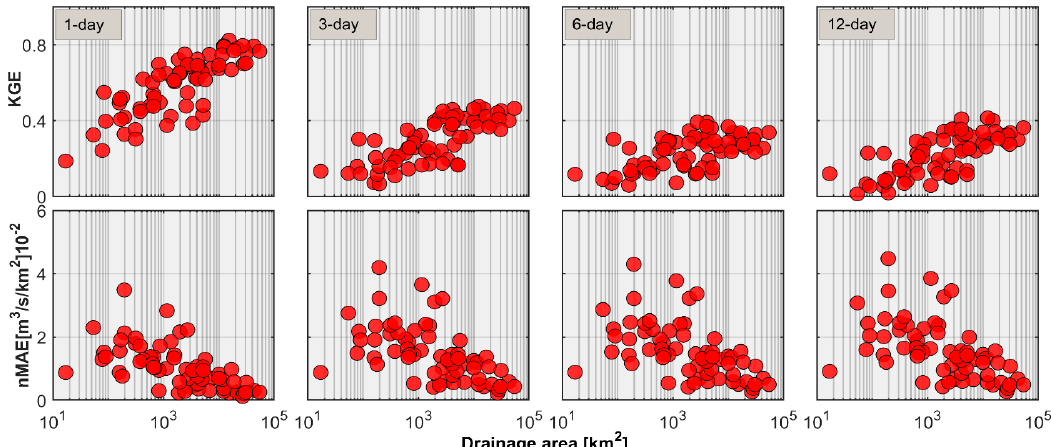
Figure 6. Relationship of skill metrics with drainage area for event-based streamflow. The columns show 1, 3, 6 and 12 day lead times, while the rows show Kling–Gupta efficiency (KGE ) and normalized mean absolute error ( nMAE ), respectively.